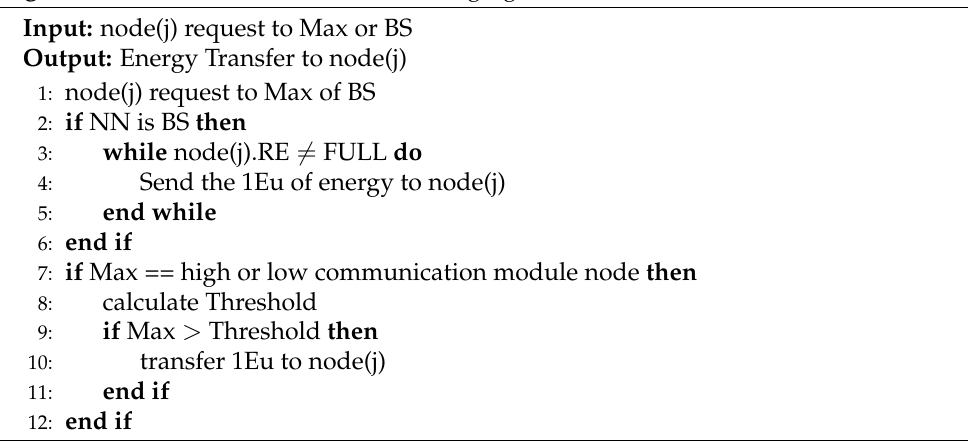
Algorithm 6 Confirmation of Node